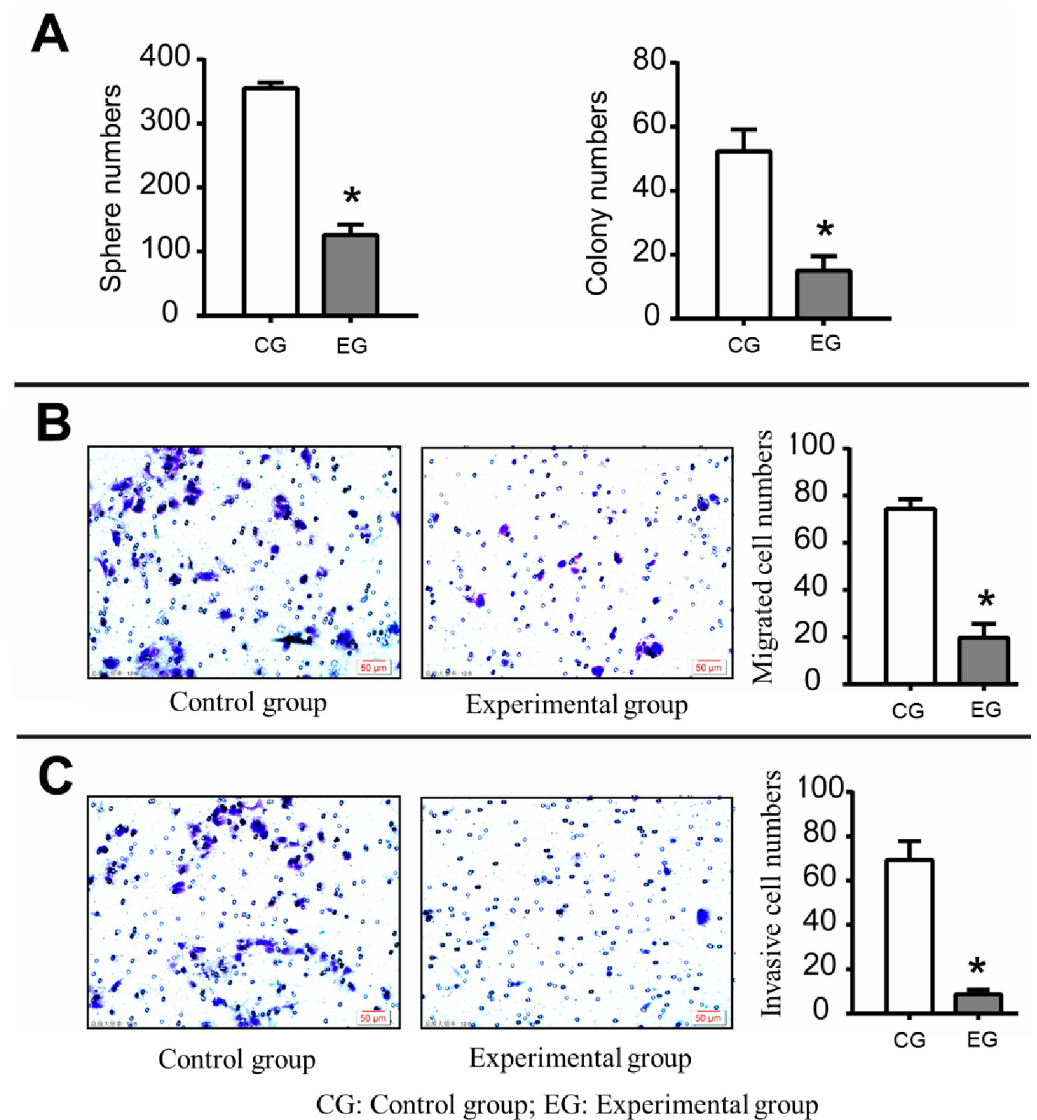
Fig 2. Effect of SB525334 on the malignant behavior of CSCs. (A) The spheres numbers and colony numbers for experimental group and control group (The cells’ self-renewal ability and colony forming ability in the experimental group are significantly weakened); (B) The migration ability of CSCs (The migration ability of CSCs in the experimental group is significantly weakened); (C) The invasion ability of CSCs (It is weakened in the experimental group); Scale bar: 50 μ m; � P <